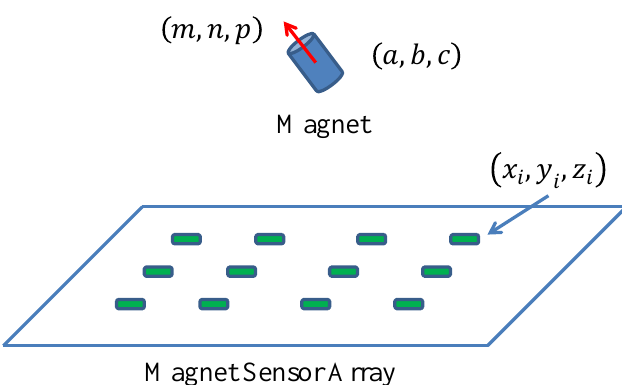
Figure 2. Magnetic tracking system. When a small magnet moves above a magnetic sensor array, its position ( a , b , c ) T and orientation ( m , n , p ) T can be estimated in real